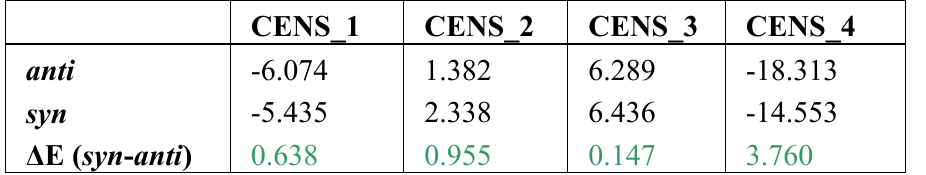
Table 5: The values of the steric energy (kcal/mol) of the anti and syn structures and the difference between these two energies as calculated by MM+.